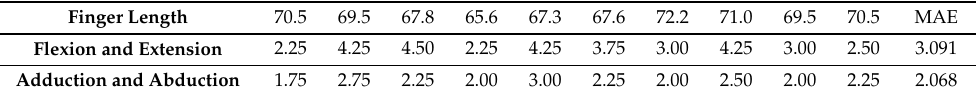
Table 3. MAE of flexion/extension and adduction/abduction for different hand